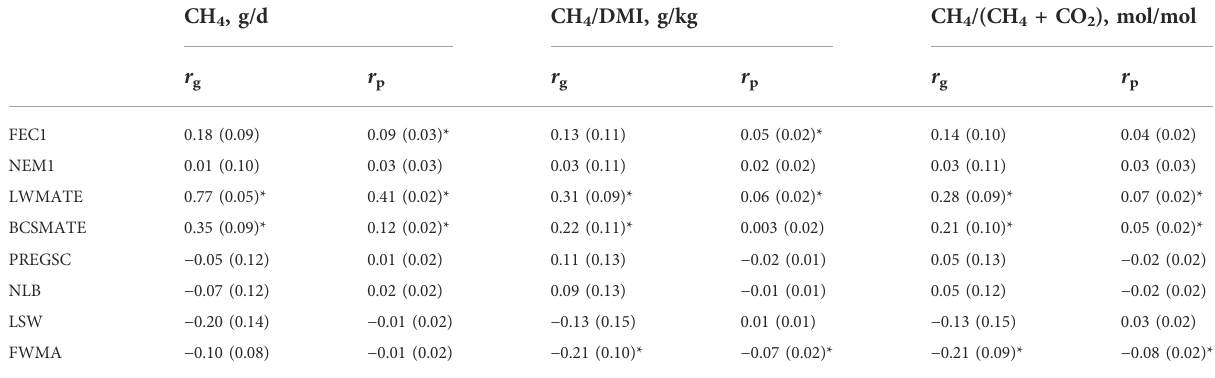
TABLE 4 Genetic ( r g ) and phenotypic ( r p ) correlations (±SE) between respiration chamber methane emissions (CH 4 , g/d), methane yield traits (CH 4 / DMI, g/kg) and (CH 4 /(CH 4 +CO 2 ), mol/mol) on a restricted diet, FEC1, NEM1 and maternal traits. Correlations signi fi cant at the 5% level ( p < 0.05) are marked with “ * ”